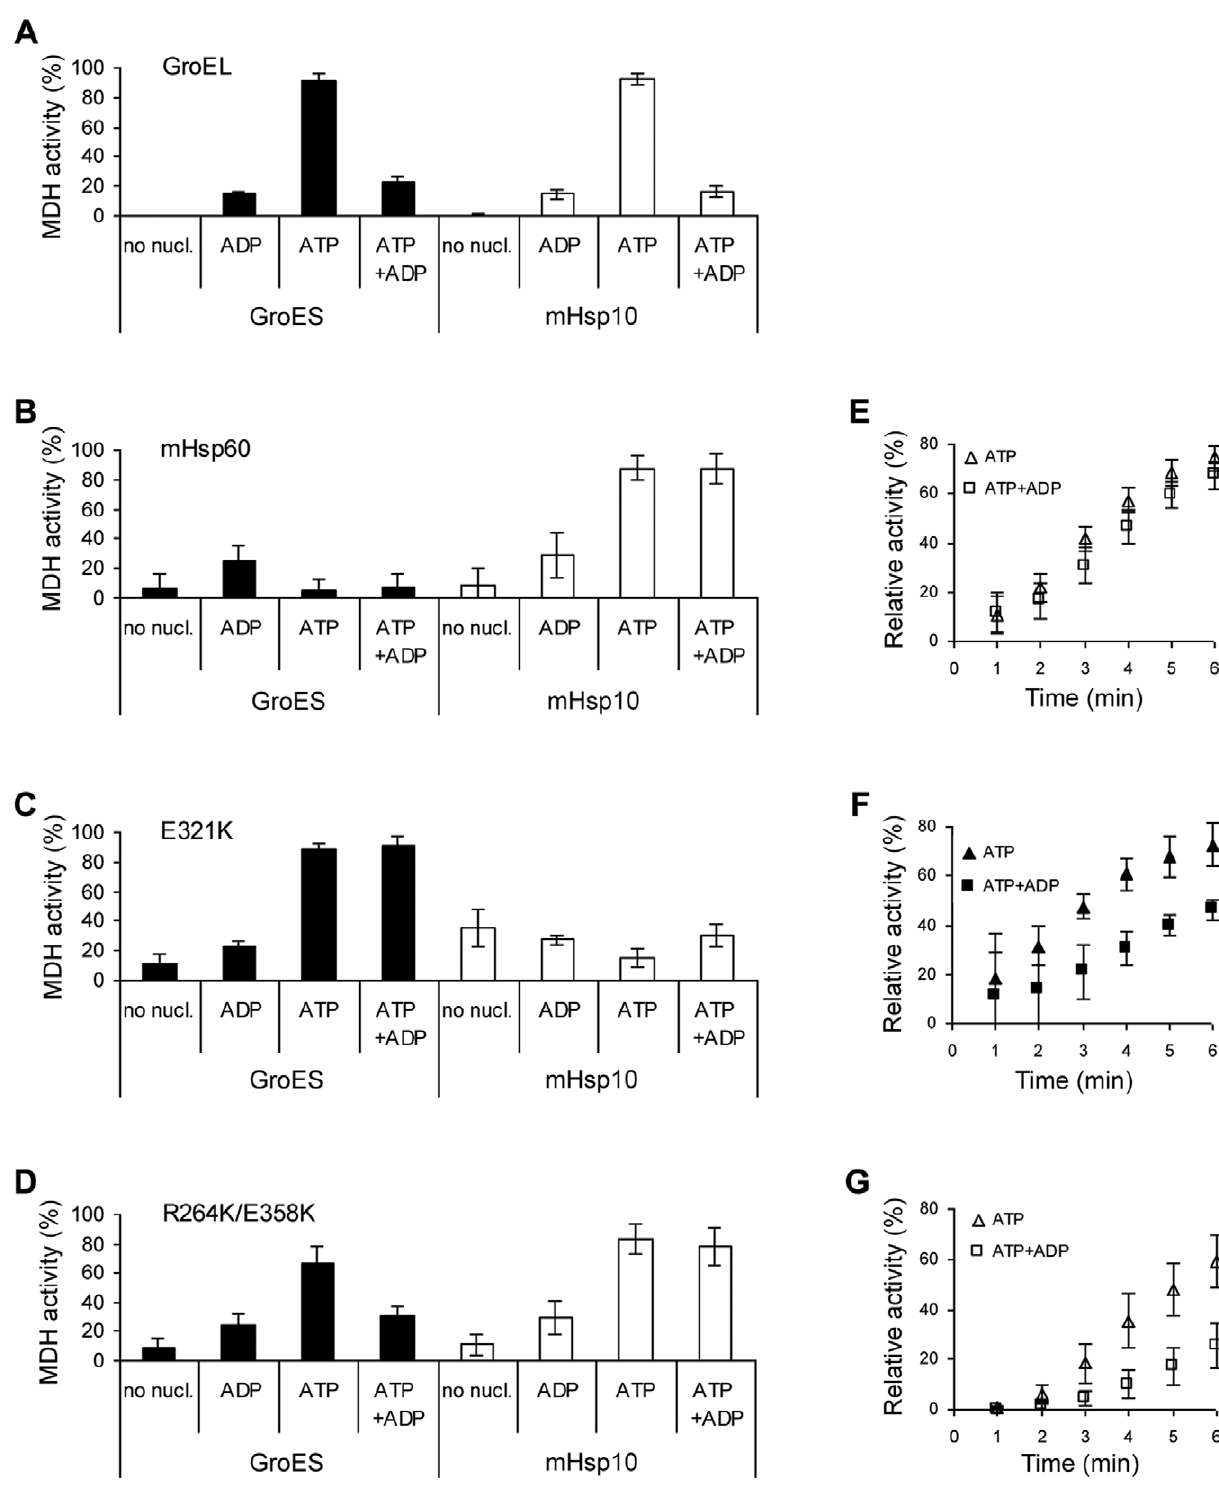
Figure 8. The inhibitory effect of ADP on MDH refolding activity by chaperonins. (A–D) Refolding of 0.33 m M HCl-denatured MDH by 10 m M of the indicated chaperonin and 40 m M of mHsp10 (white columns) or GroES (black columns). MDH activity was measured at 340 nm following a 60 min incubation at 30 u C in the absence of nucleotides or in the presence of 10 mM ADP, 1 mM ATP or 1 mM ATP + 10 mM ADP as indicated. The activity following refolding is presented relative to that of native MDH (100%). (E–G) Time-dependent refolding activity of wild-type mHsp60 (E), E321K mutant (F) and R264K/E358K mutant (G) together with mHsp10 (white symbols) or GroES (black symbols) in the presence of 1 mM ATP (triangles) or 1 mM ATP + 10 mM ADP (squares). The relative activity is compared to the activity measured by each chaperonin pair after 30 min in the presence of ATP (100%).